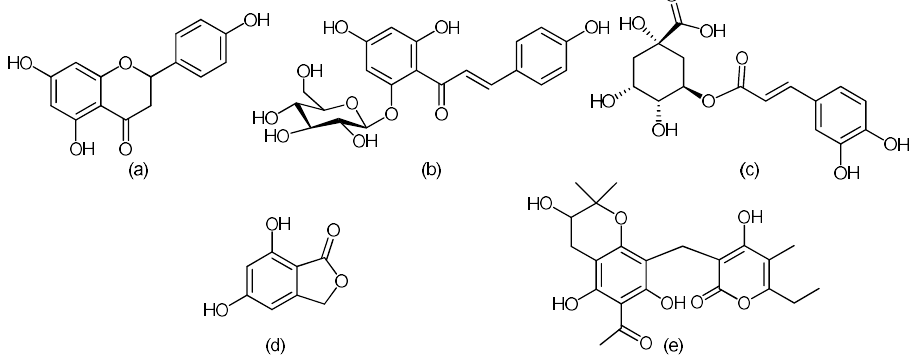
Figure 1. Phenolic representatives of H. plicatum : ( a ) naringenin (flavanone), ( b ) isosalipurposide (chalcone), ( c ) chlorogenic acid (phenolic acid ester), ( d ) 5,7-dihydroxyphthalide (phthalide), ( e ) plicatipyrone (chromanyl α-pyrone).